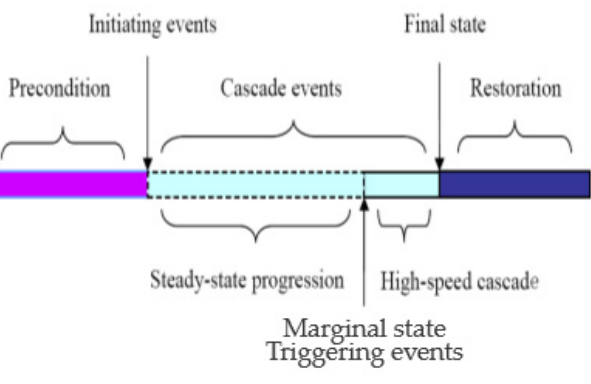
Figure 7. Typical stages of a cascading system emergency [44].